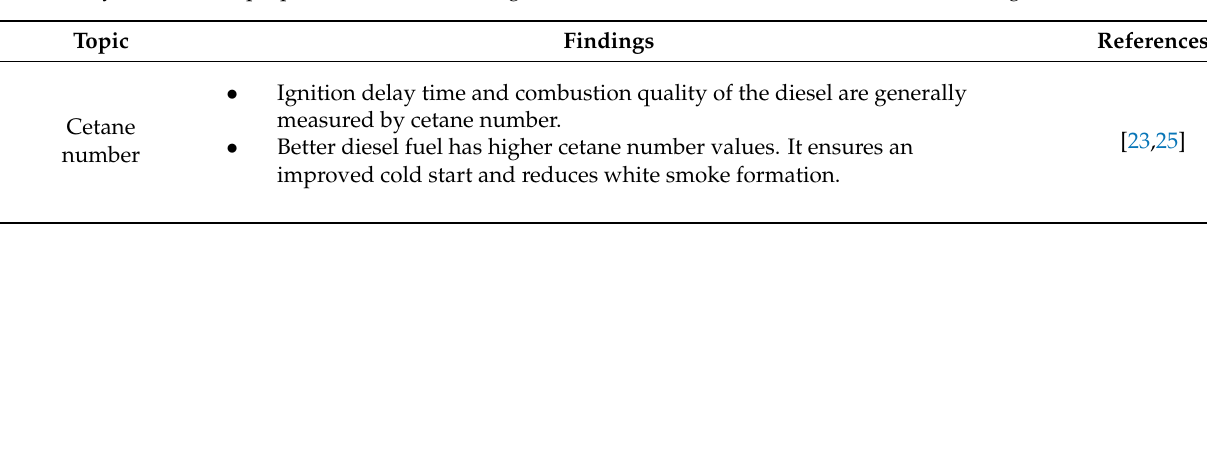
Table 2. Physicochemical properties of waste cooking oil biodiesel blended with diesel fuel in diesel